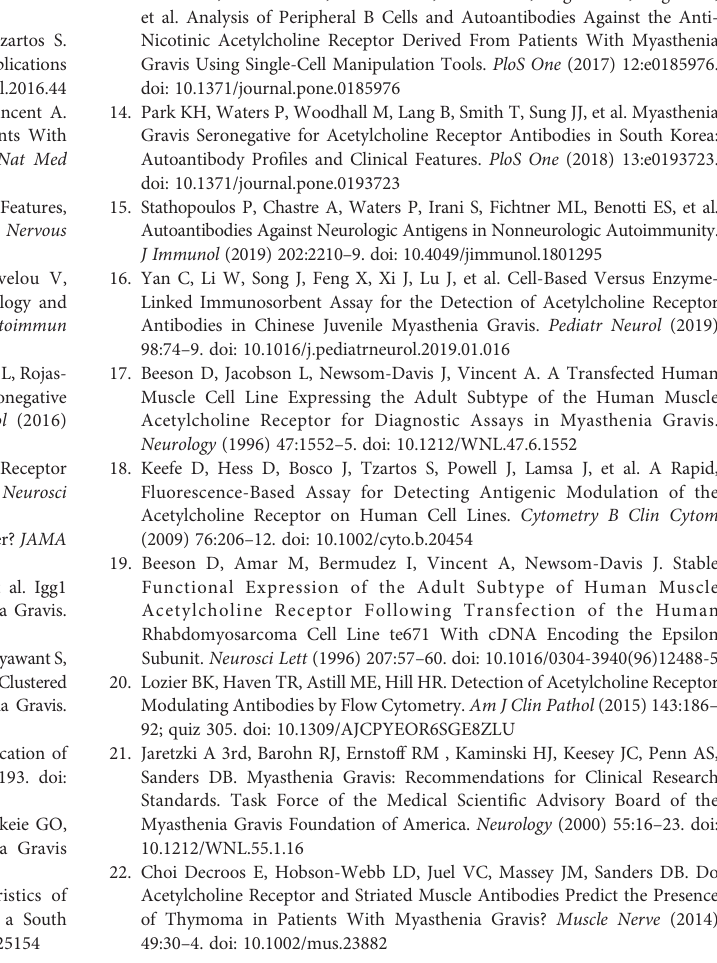
Supplementary Figure 1 | Expression of AChR subunits and rapsyn in uninfected HEK293T cells. Double immuno fl uorescence staining with 4 ′ ,6- diamidino-2-phenylindole (DAPI, blue), AChR subunits (red) and rapsyn (red) in the stable cell line KL525. Bar, 100 m